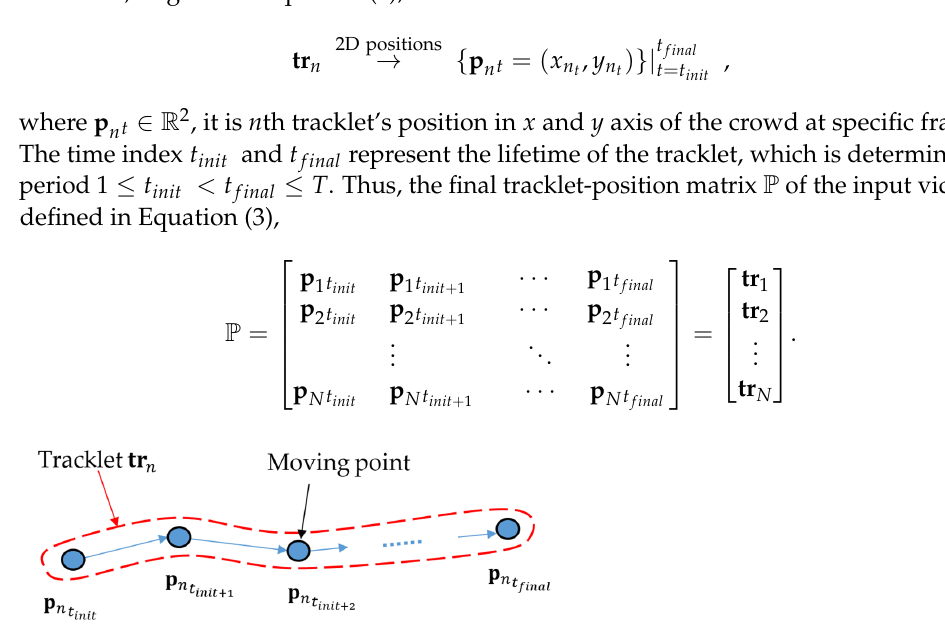
Figure 2. One single KLT tracklet tr n with its initial and final lifetime points.